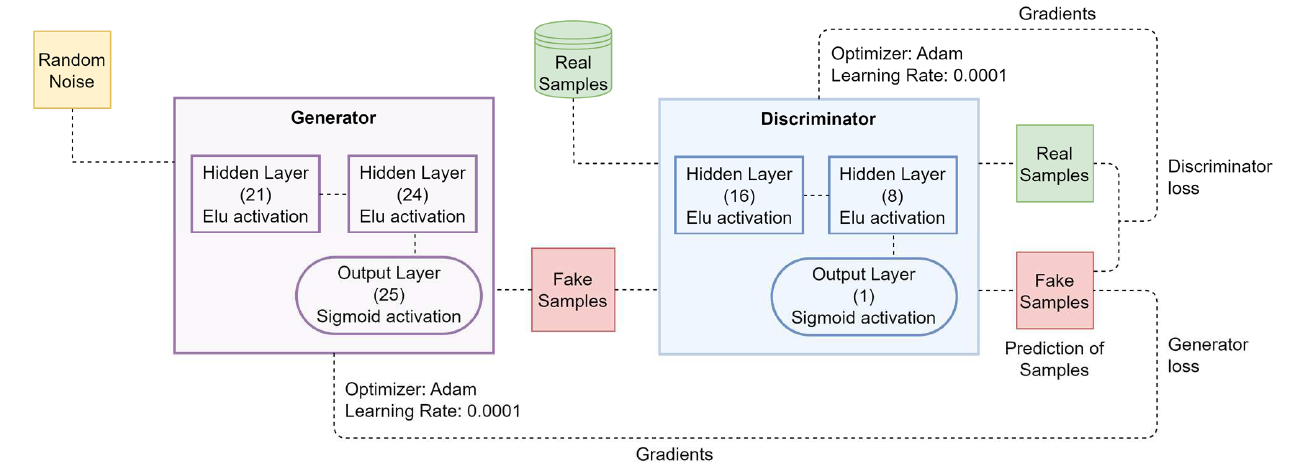
Figure 3. Block diagram of the proposed GAN model.